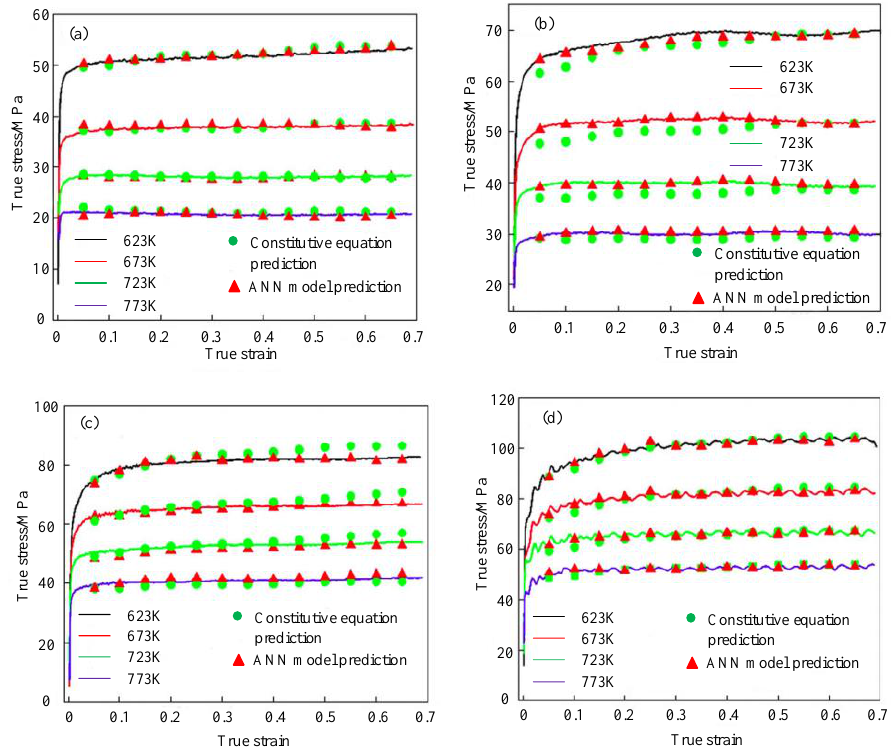
Figure 24. The predicted results of aluminum alloy based on ANN molde [66], ( a ) 0.01 s − 1 ; ( b ) 0.1 s − 1 ; ( c ) 1 s − 1 ; ( d ) 10 s − 1 .